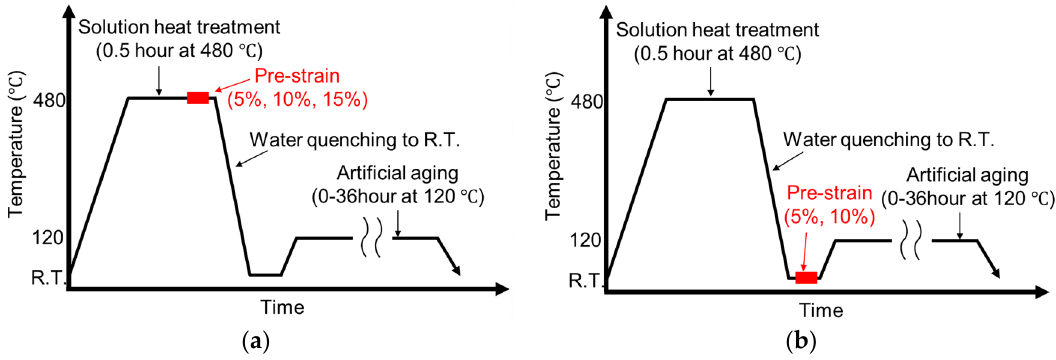
Figure 2. Experimental schedules of the T6 treatment conditions with pre-straining at ( a ) 480 °C as hot-stamping and ( b ) RT after quenching.